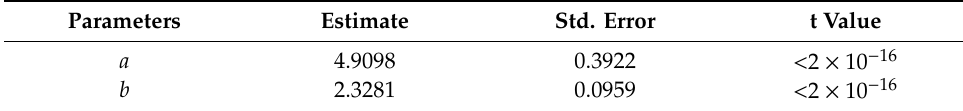
Table 2. Summary information of the tree- and plot-level ground